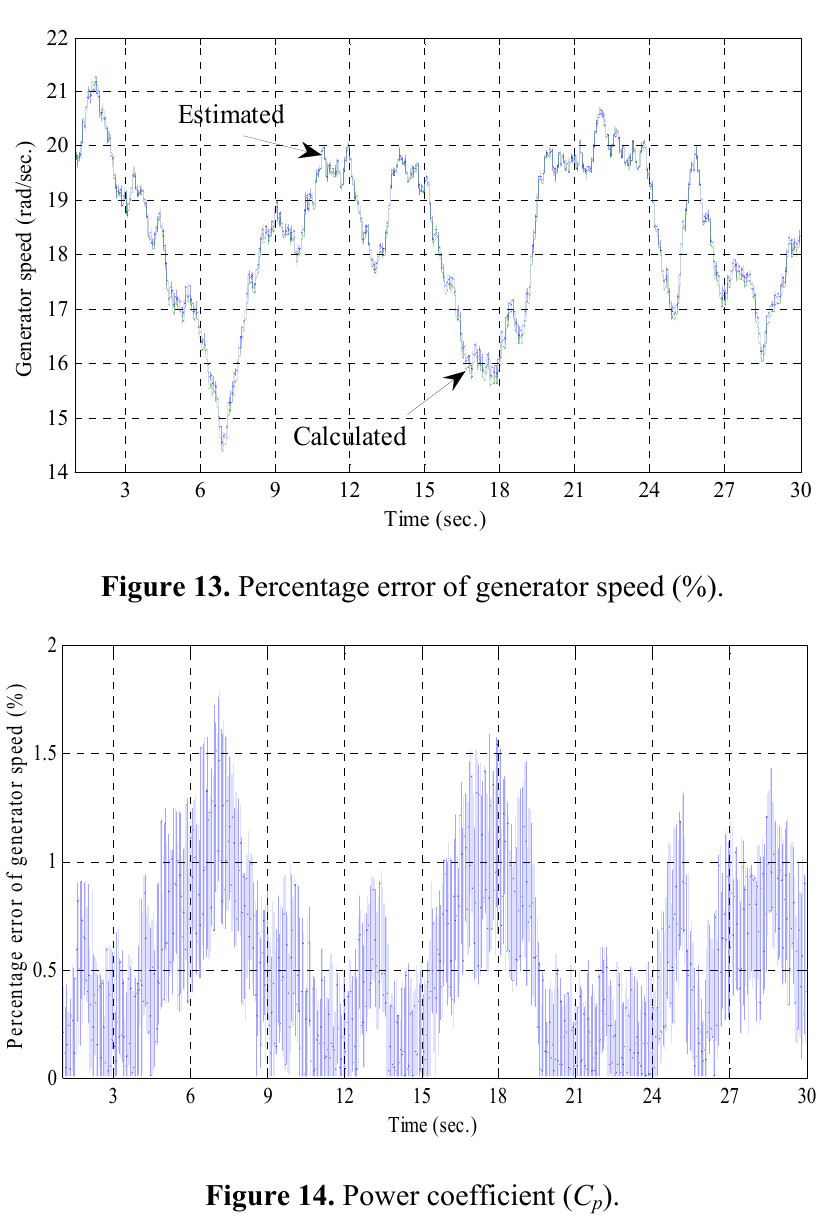
Figure 12. Estimated and calculated generator speed (rad/second).